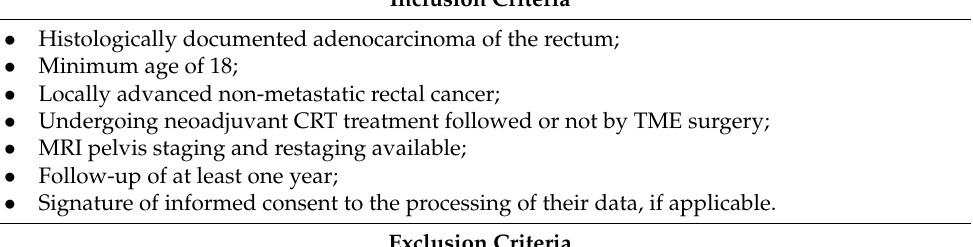
Table 1. Inclusion criteria.